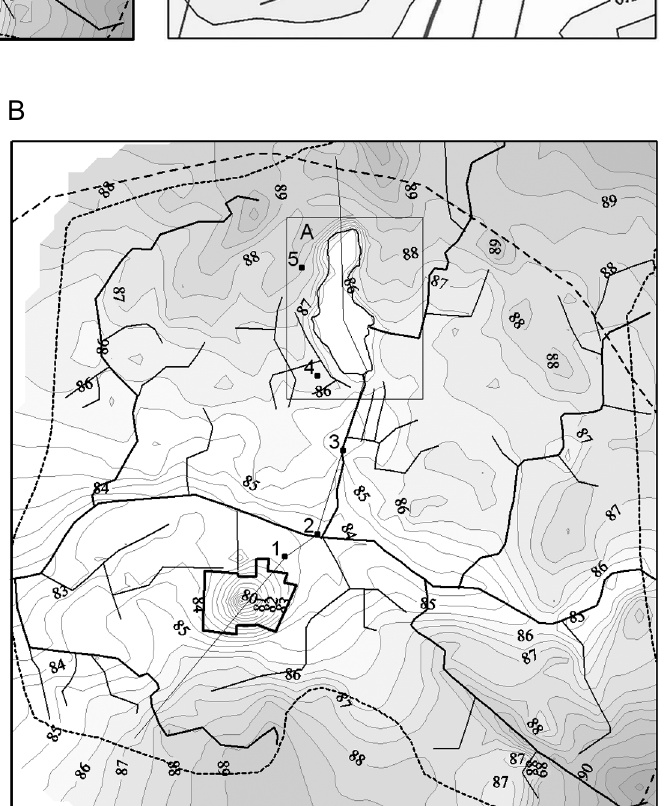
Fig. 8. Simulated groundwater level (m a.s.l) of the Č edasai area: A , according to the natural groundwater regime prior to the beginning of exploitation of the dolomite quarry; B , according to the affected groundwater regime, after eight years of exploitation of the dolomite quarry; C , simulated drawdown of groundwater level (m) in the area of Lake Č edasas (marked with A in part B of the figure). 1(cid:150)5, observation